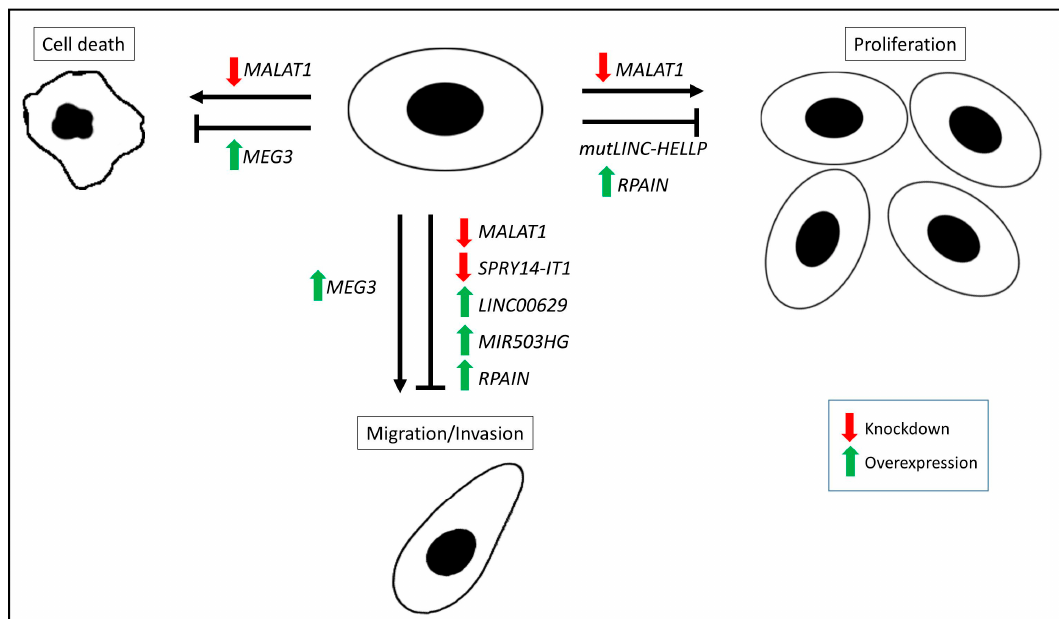
Figure 2. Summary of the roles and function of lncRNAs in trophoblast cells. MALAT1 and MEG3 expression influence trophoblast cell death while MALAT1 , RPAIN and mutLINC-HELLP influence trophoblast proliferation. Altered MALAT1 , SPRY14-IT1 , LINC00629 , MIR503HG , RPAIN and MEG3 expression is associated with changes in trophoblast migration and invasion. Green arrows indicate overexpression of the lncRNA and the impact on cell death, proliferation or migration/invasion while red arrows denote knockdown of lncRNAs and resultant changes in trophoblast function as measured by cell death, proliferation or migration/invasion assays. Black arrows indicate altered gene expression promotes/increases trophoblast function. Black T-bar indicates altered gene expression reduces trophoblast function.